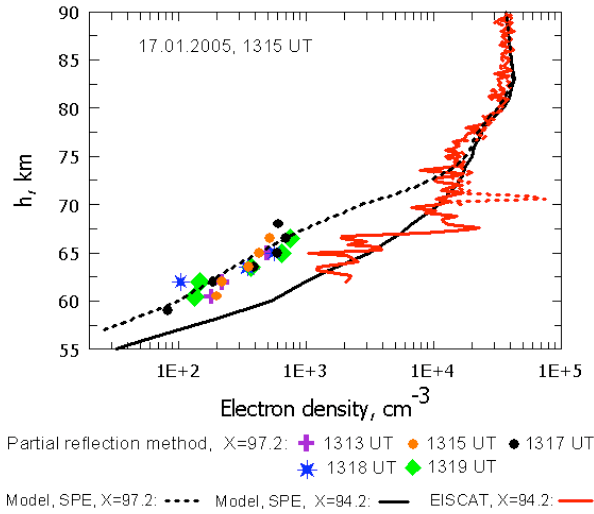
Fig. 10b. Electron density profiles measured (red curve and sym- bols) and calculated for the SPE on 17 January 2005 at 13:45UT for zenith angles 95.8 ◦ and 100.5 ◦ using the O, O 3 and NO profiles 4–6 in Fig. 1 (black